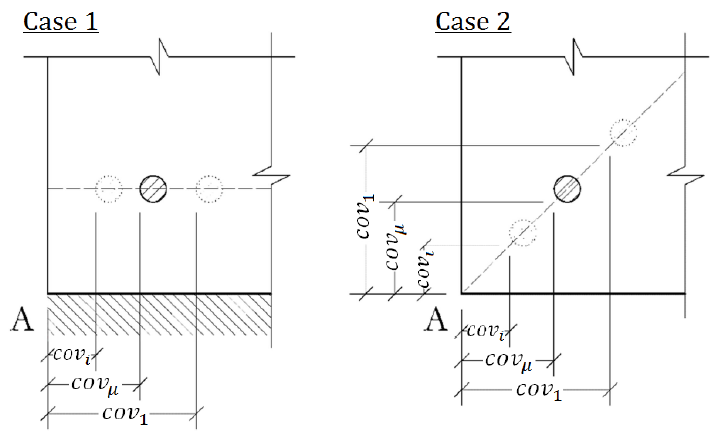
Figure 4. Cover values for chloride concentration assessment. Case 1 and Case 2.